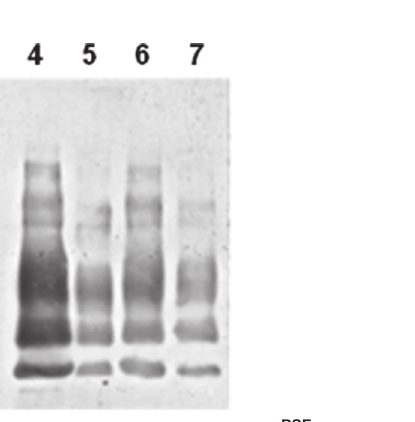
Figure 4. Immunoblotting detection of the persistent PrP BSE -infected cell according to serial passages. The lysates of brain homogenates (lane 1; BSE-noninfected bovine brain, lane 2; BSE-infected bovine brain-original BSE source) and MDBK cells expressing normal bovine prion protein by using infectious recombinant lentivirus (lane 3: transduced MDBK – MBDK C1 – 2F – passage(p) 7; lane 4: BSE-infected transduced MDBK (M2B) – p17; lane 5: M2B-p48; lane 6: M2B-p70 and lane 7: M2B-p83) were treated with proteinase K (PK) for detection of PrP BSE in transduced MDBK which was sequentially passaged